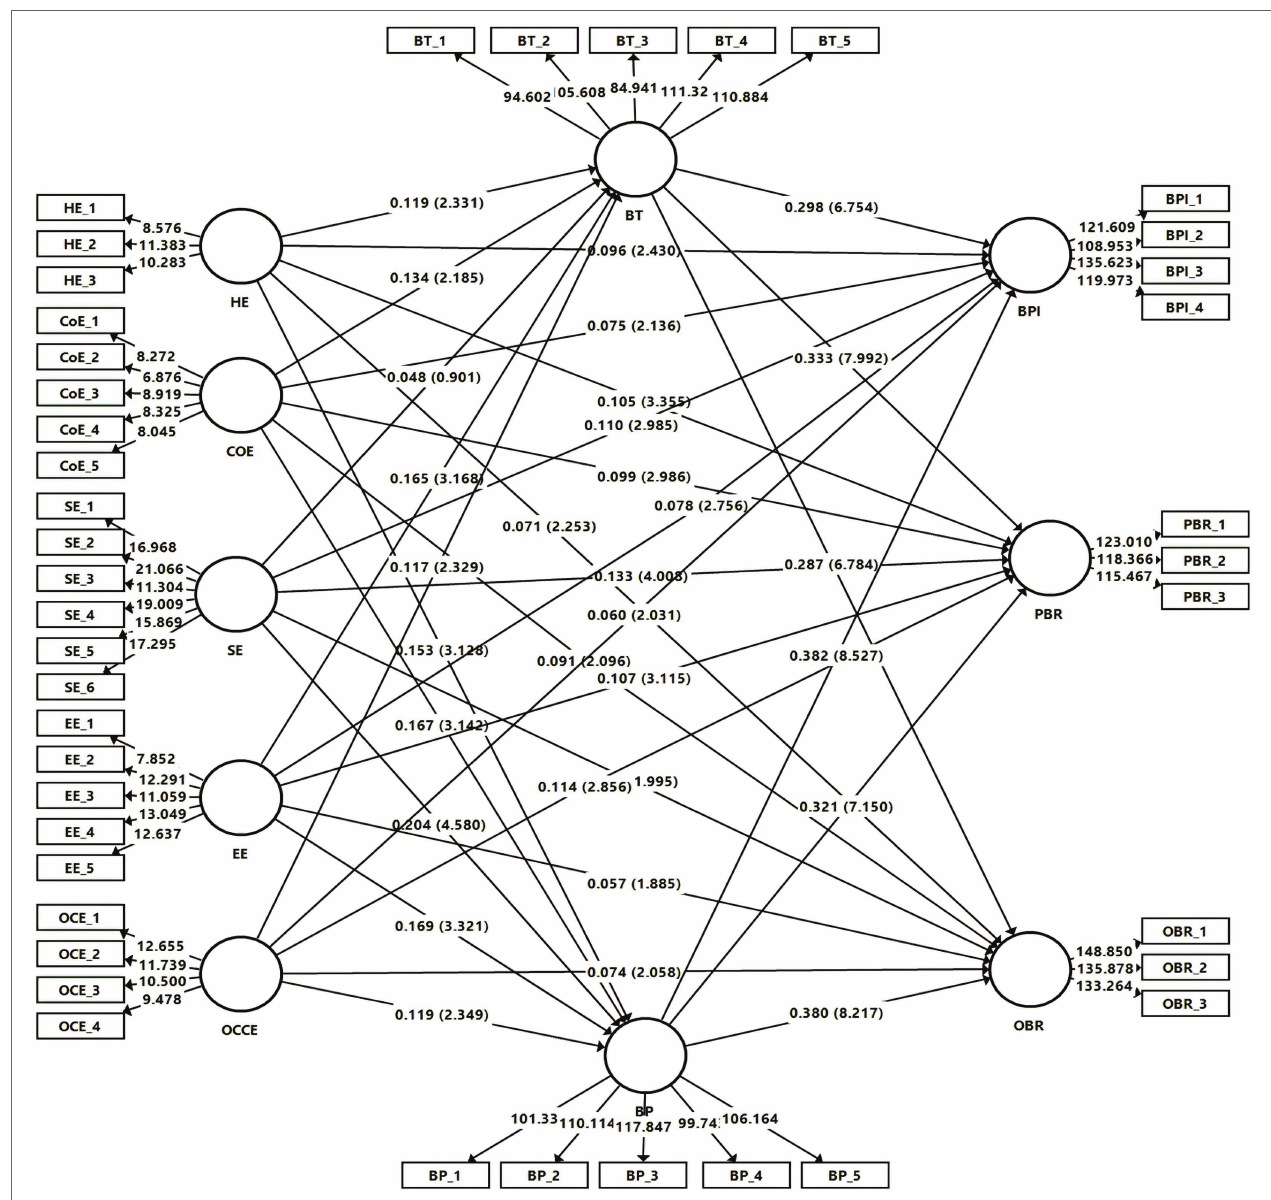
FIGURE 2 | Assessment of Structural Model.